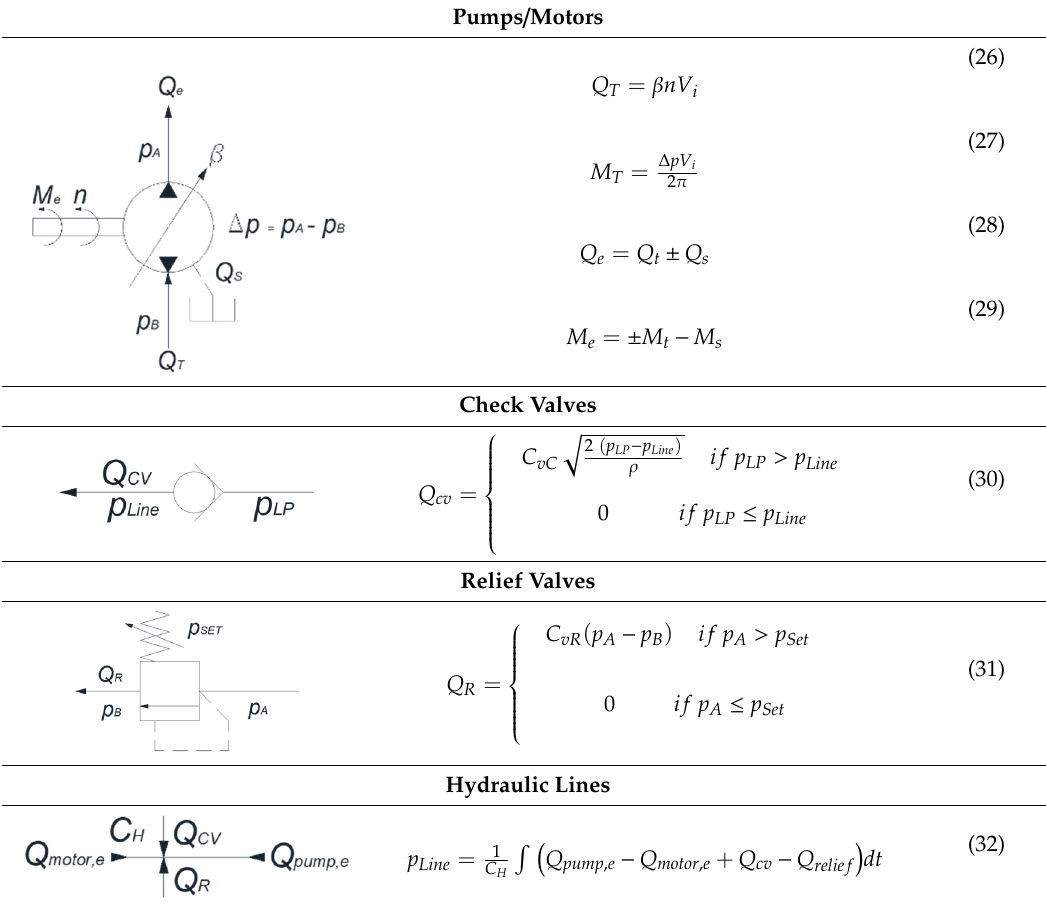
Table 2. System modeling equations.